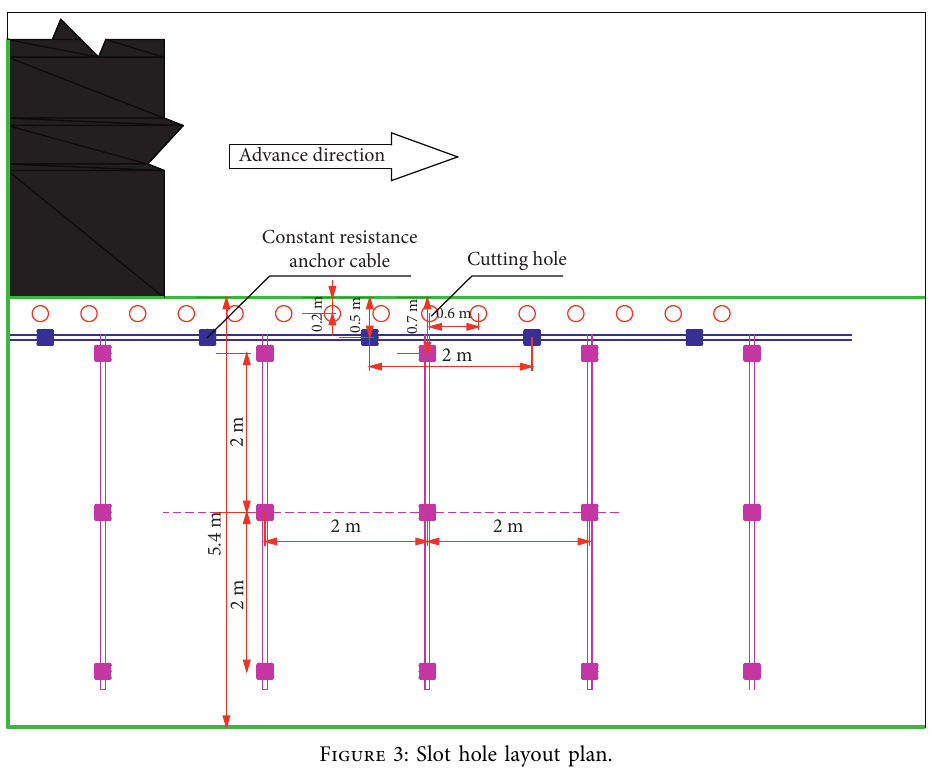
Figure 3: Slot hole layout plan.